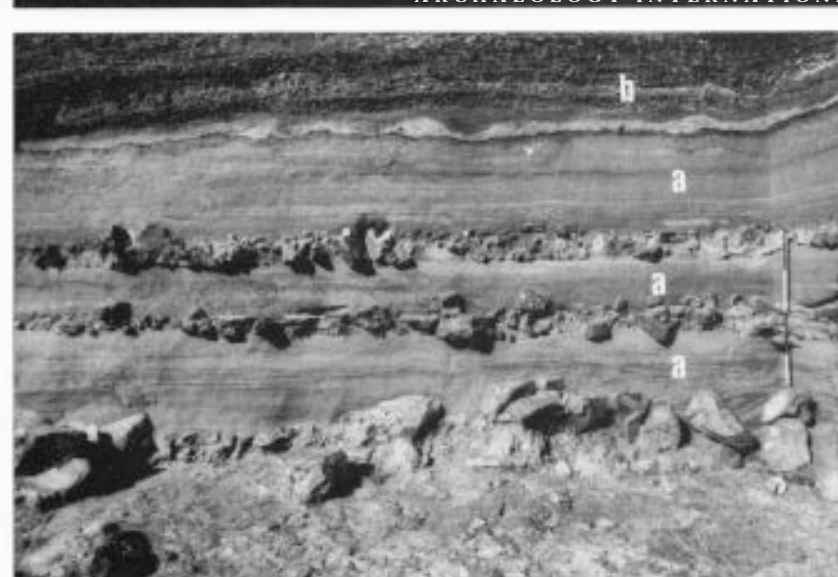
Figure 6 The Boxgrove type section at GTP 13, showing the sediments of the largely marine Slindon Formation (a) and the terrestrial Eartham Formation (b); scale in O.Sm divisions.